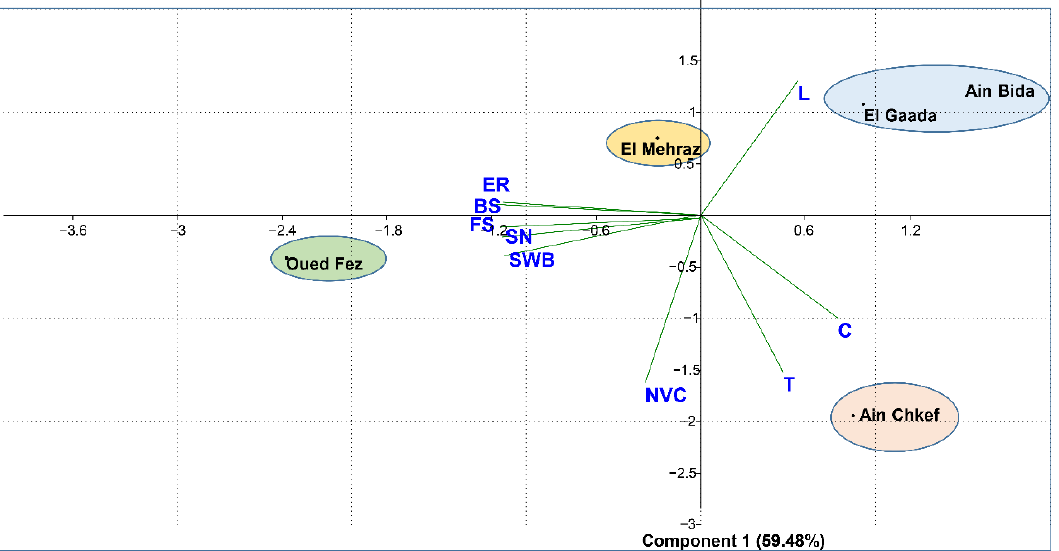
Figure 4. Summary of principal factors disturbing the avian diversity and their habitats in Fez peri- urban area (BS: bird species, C: cars, ER: egg robbery, FS: fishing activity, L: livestock, NVC: natural vegetation cover, SN: sanitation tunnels, SWB: surface of water body, T: tourists).